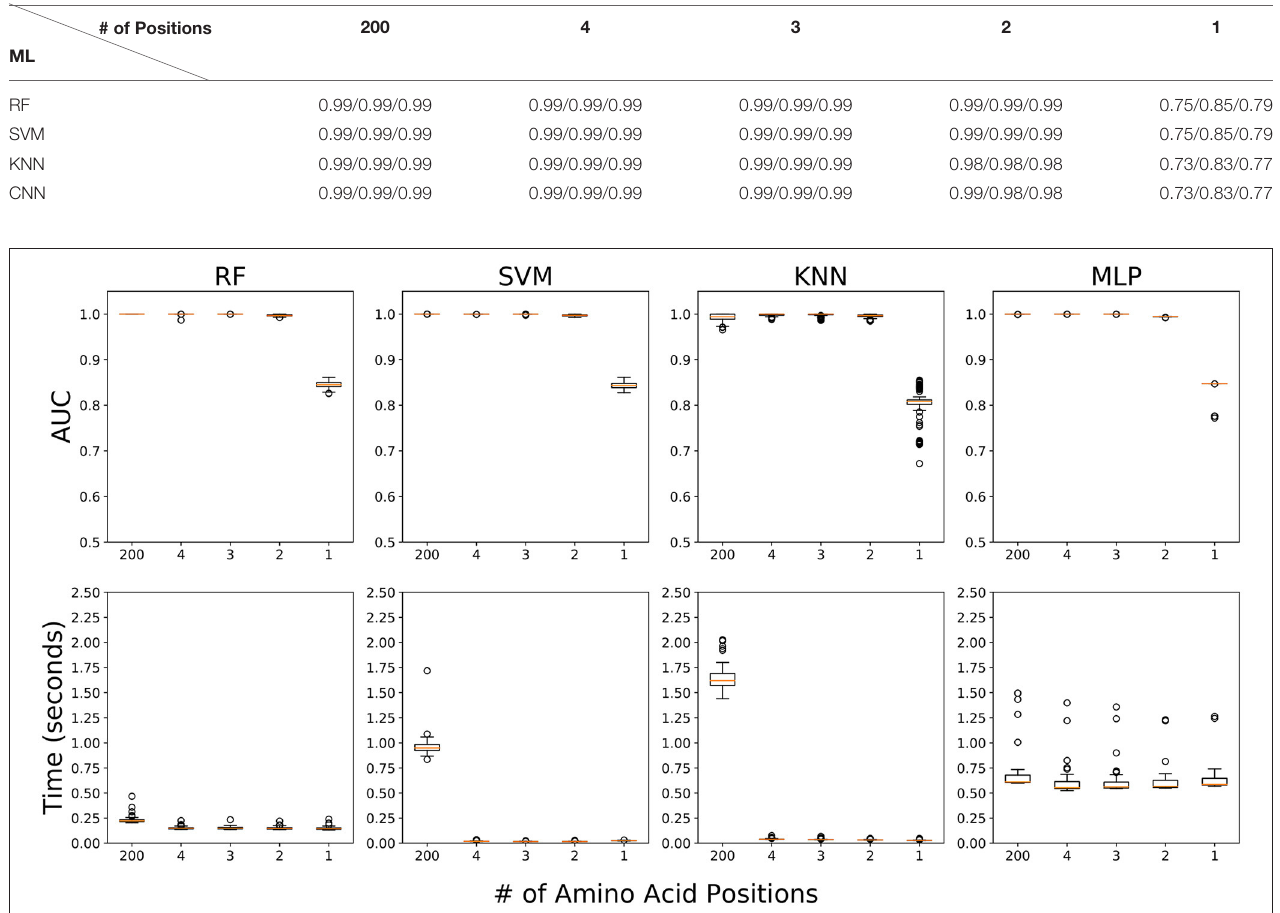
FIGURE 5 | Accuracy and time consumption of four machine learning algorithms in five experiments for PRRSV classification. First experiment fully includes 200 amino acid positions and other four experiments sequentially involved the top 4 amino acid positions [26th, 170th, 137th, and 191st] by their importance score. Top: area under the curve (AUC) values. Bottom: time consumption (seconds). Orange lines are mean values over 100 runs.